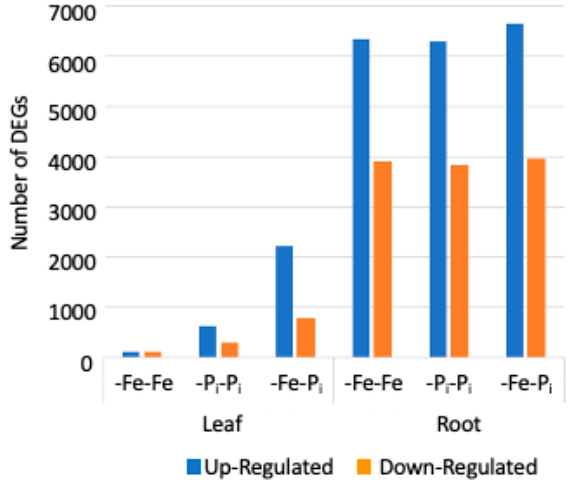
Figure 3. Distribution of DEGs in leaves and roots in this study (-Fe-P i ) and in repeated stress exposure samples (iron stress, -Fe-Fe or phosphate stress, -P i -P i ) from previous study [34]. The number of DEGs is significantly higher in leaves exposed to sequential stress (-Fe-P i ) than in repeated stress samples while the number of DEGs in roots is consistent regardless of the stress exposure.